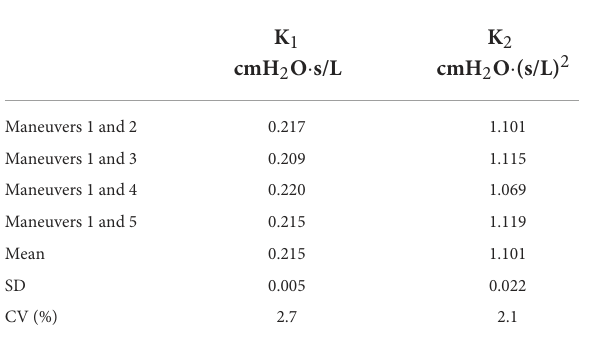
TABLE 2 K 1 and K 2 of the low-cost pneumotachograph when measured from two manual maneuvers (Table 1).